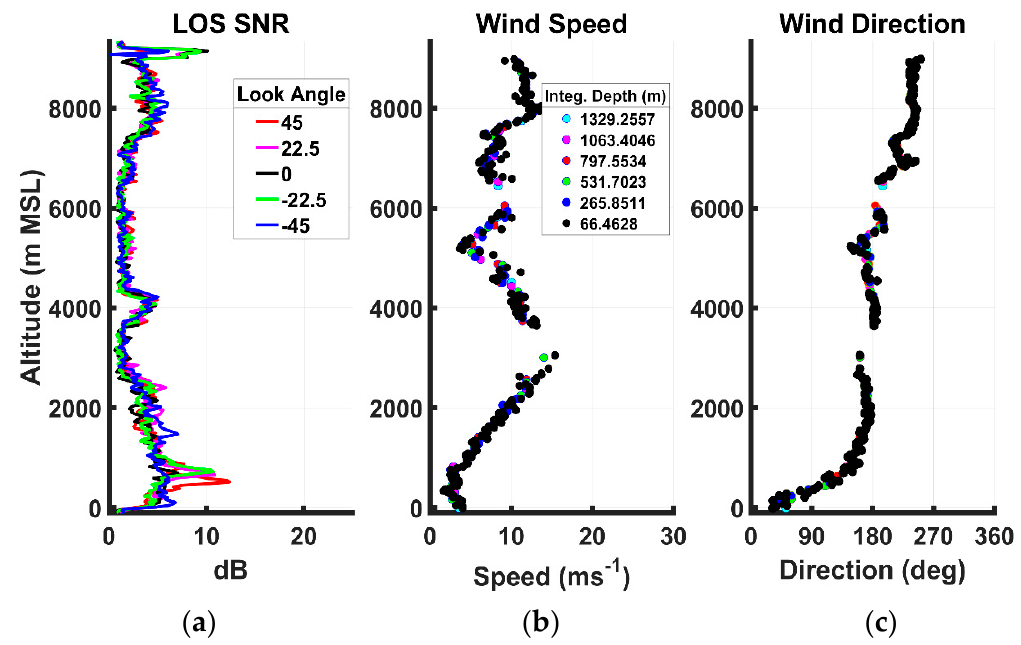
Figure 24. DAWN vertical profiles of SNR ( a ), wind speed ( b ) and wind direction ( c ) in inflow region of convection at 182117Z on 11 June 2017.